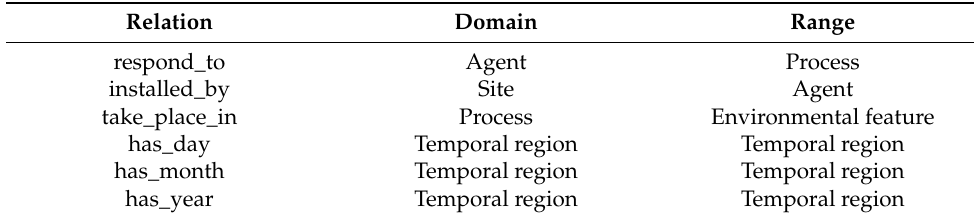
Table 4. POLARISCO relations.